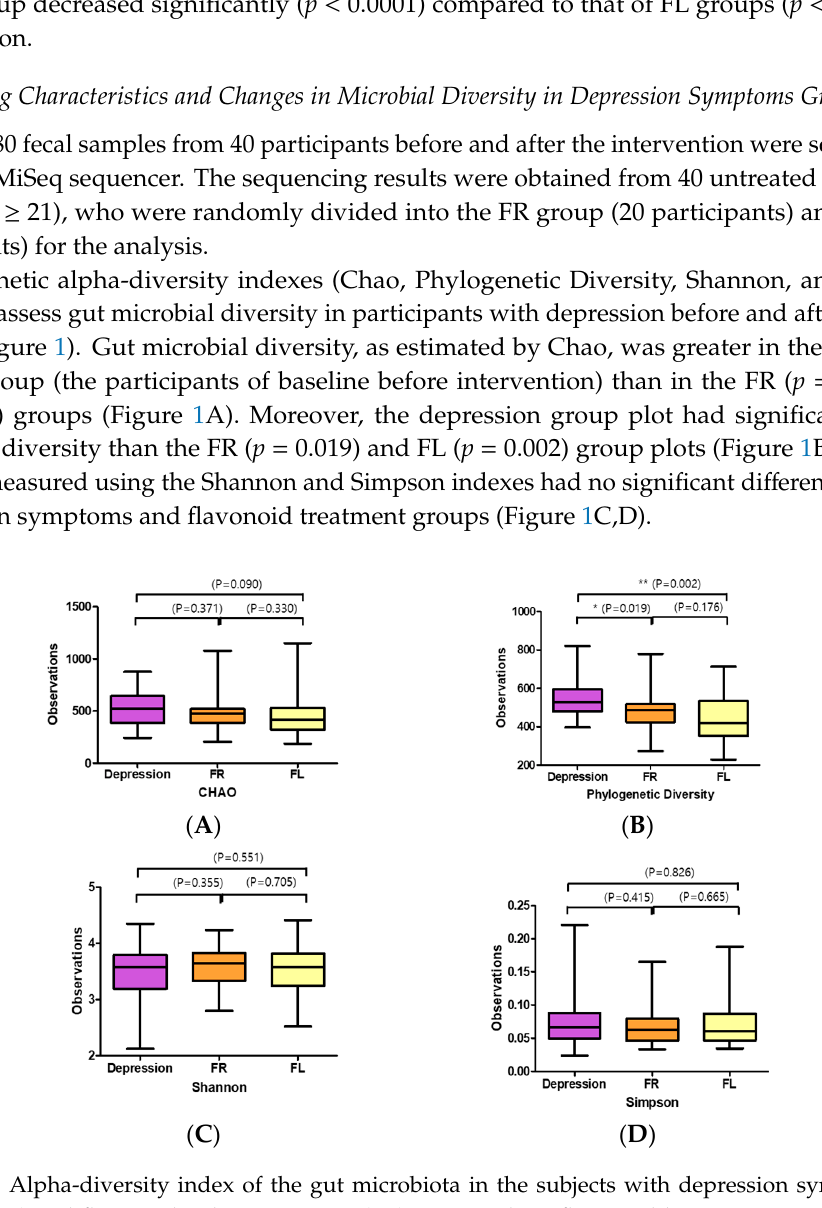
Figure 1. Alpha-diversity index of the gut microbiota in the subjects with depression symptoms (depression) and flavonoid-rich orange juice (FR) or equicaloric flavonoid-low orange cordial (FL) treatment groups: ( A ) Chao 1, ( B ) phylogenic diversity, ( C ) Shannon, and ( D ) Simpson. Box plots depict greater gut microbial diversity in the flavonoid-rich orange juice (FR) group than in the depression symptoms group (Depression; the participants of baseline before intervention) or flavonoid-low orange cordial (FL), according to the Shannon and Simpson indexes. The horizontal lines in the box plots represent median values; upper (Q3) and lower (Q1) ranges of the box represent the 75% and 25% quartiles, respectively.